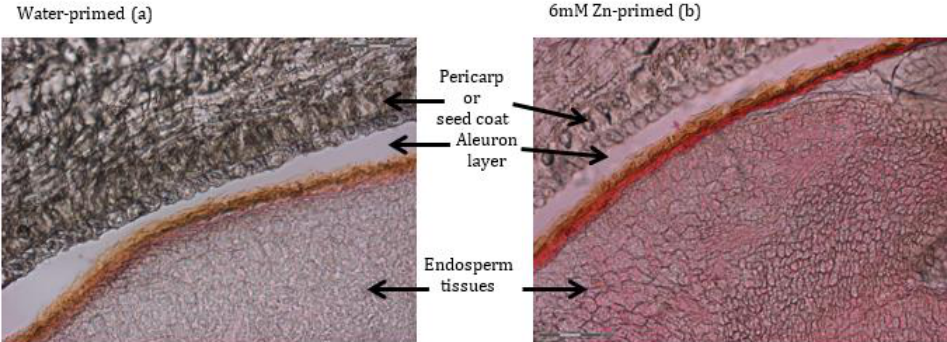
Figure 4. DTZ-staining of Zn in a spinach seed of water-primed ( a ) and Zn-primed ( b ) seedlings with 6 mM ZnSO 4 · 7H 2 O. Red staining indicates Zn localization, especially in the aleurone layer, endosperm, and pericarp.